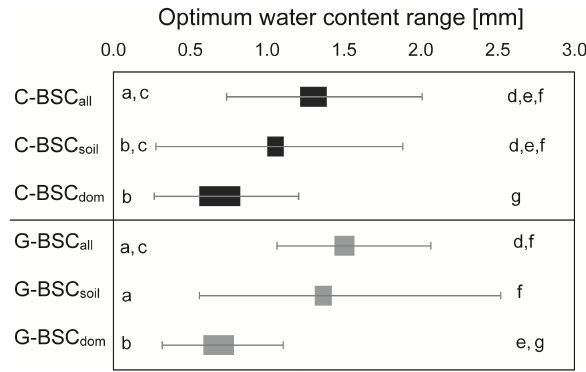
Figure 5. Optimum water content range, in mm precipitation, of a cyanobacteria-dominated BSC (upper three, black bars) and a green-algae-dominated BSC (lower three, grey bars) and their re- spective separated components. Sample size is n = 24 for all C-BSC and 16 for all G-BSC. Letters represent statistical differences of the upper and lower limits, respectively (a, b, c = lower limit; d, e, f, g = upper